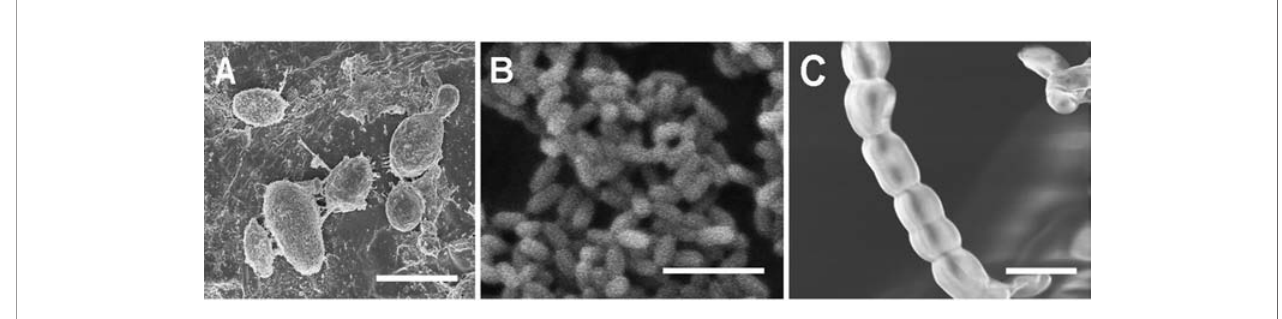
FIGURE 1 | Scanning electron micrographs of single-celled spore types with different morphologies produced by Neopseudocercosporella capsellae during morphological transformation from hyphae-to-yeast. (A) Unicellular meso-blastospores. (B) Unicellular micro-blastospores. (C) Arthrospore chain. Scale bars =